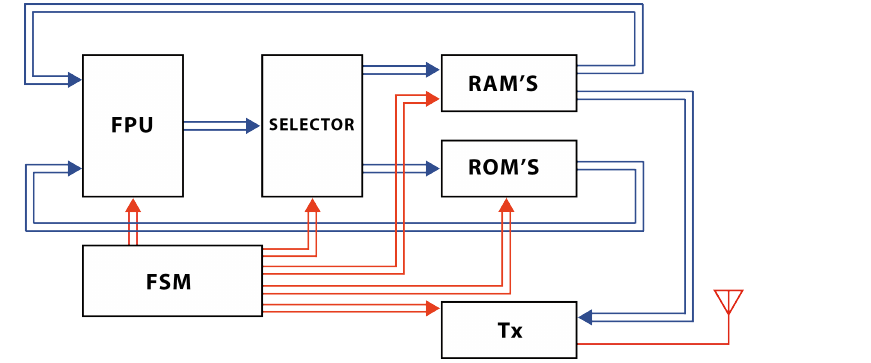
Figure 9. Block diagram of the FPGA